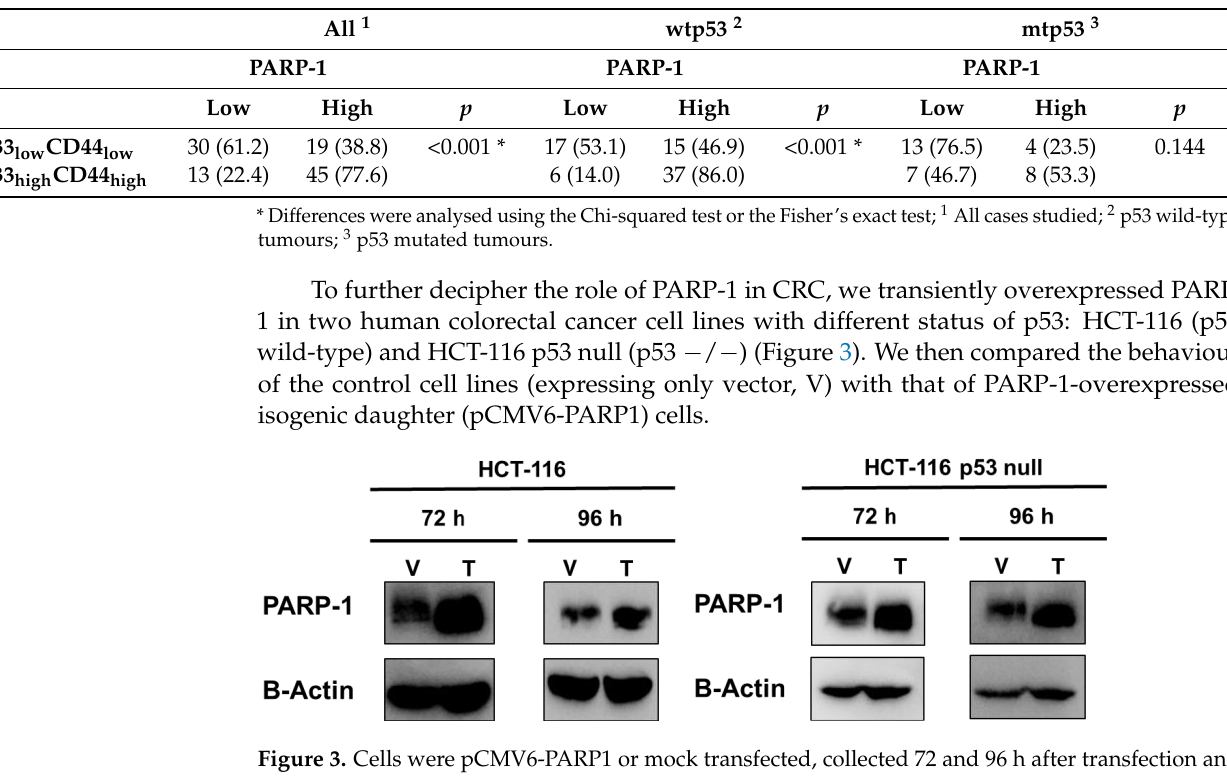
Table 3. Relationship of PARP-1 and CSC marker expression in our cohort of CRC patients according to p53 status.